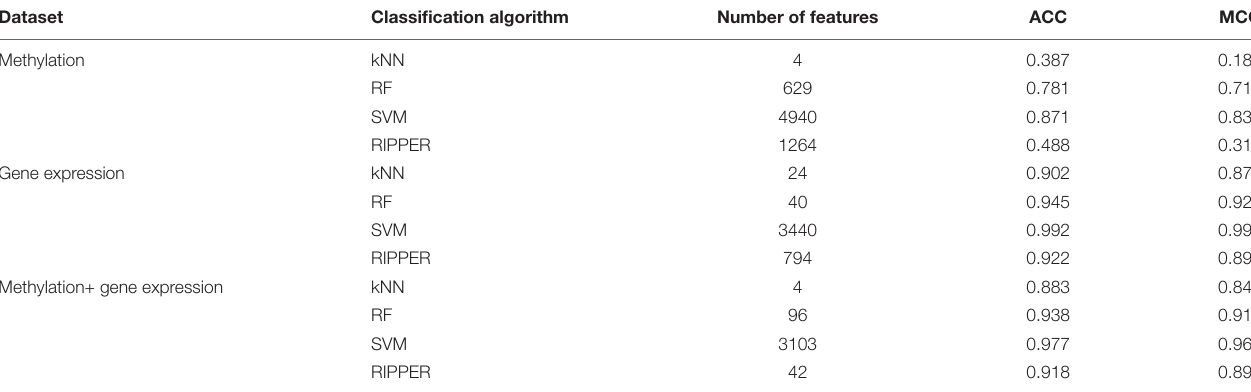
TABLE 1 | Performance of the best classification model on three datasets with different classification algorithms. Dataset Classification